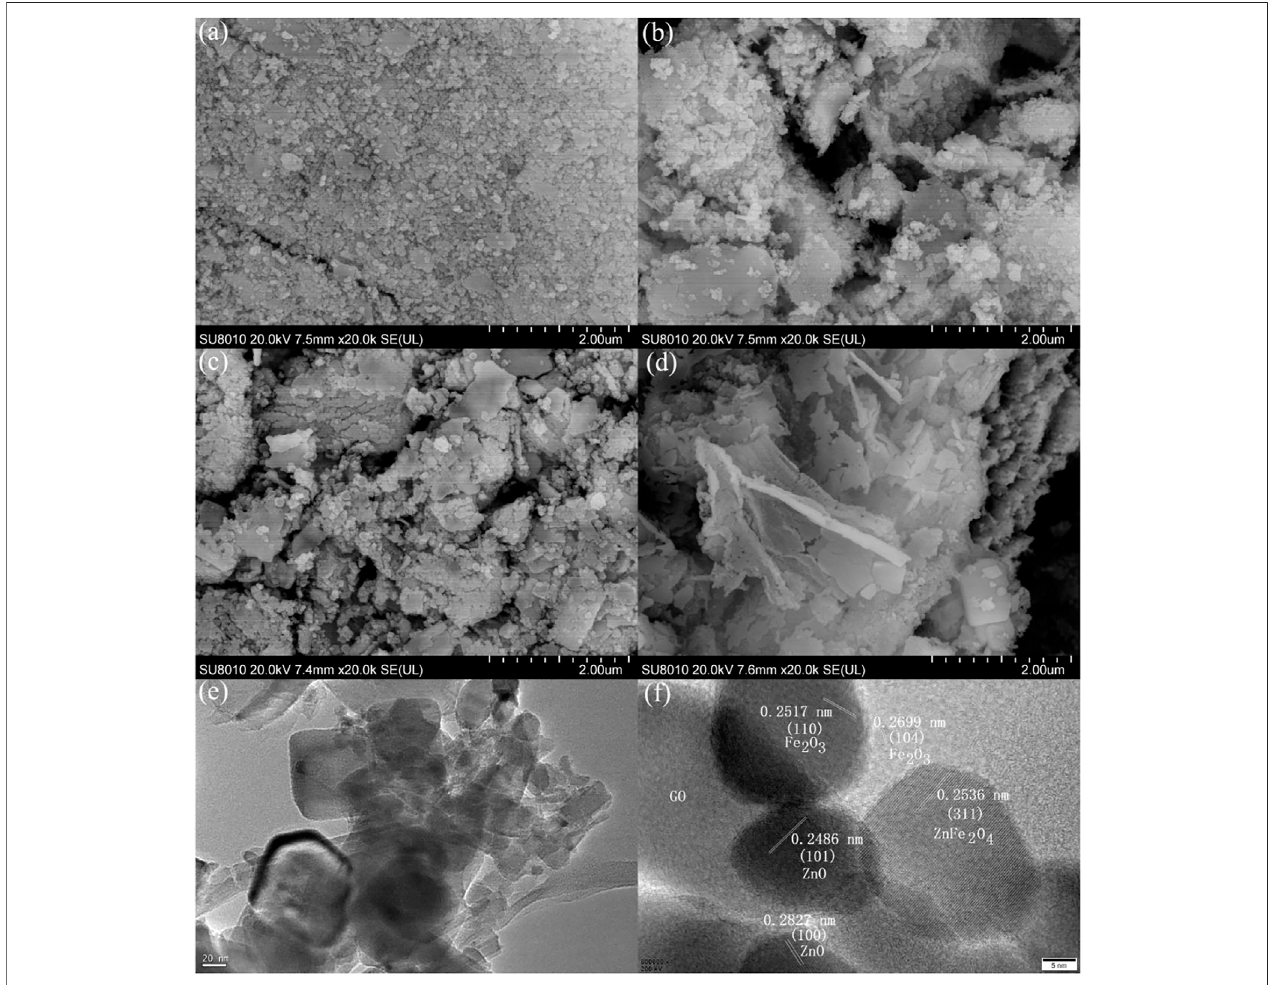
FIGURE 5 | SEM images of samples (A) GO/ZO/FO/ZFO1, (B) GO/ZO/FO/ZFO2, (C) GO/ZO/FO/ZFO3, and (D) GO/ZO/FO/ZFO4. (E) TEM and (F) HRTEM images of the sample GO/ZO/FO/ZFO3.